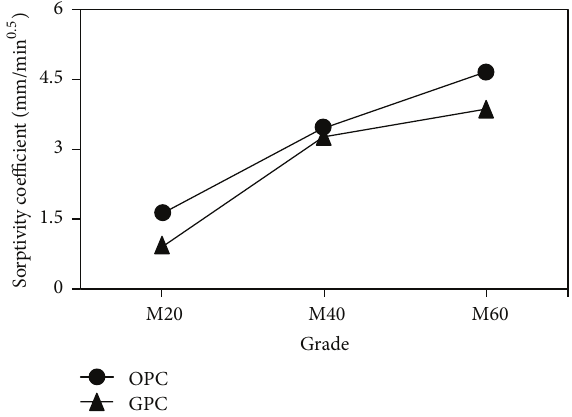
Figure 1: Sorptivity Co efficient for OPC and GPC.